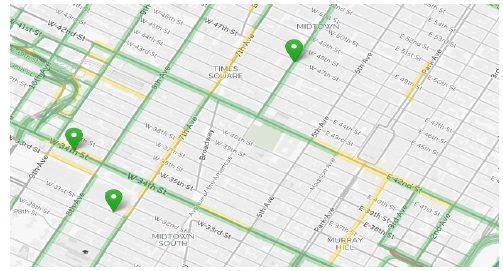
Figure 4: Streets traffic for a